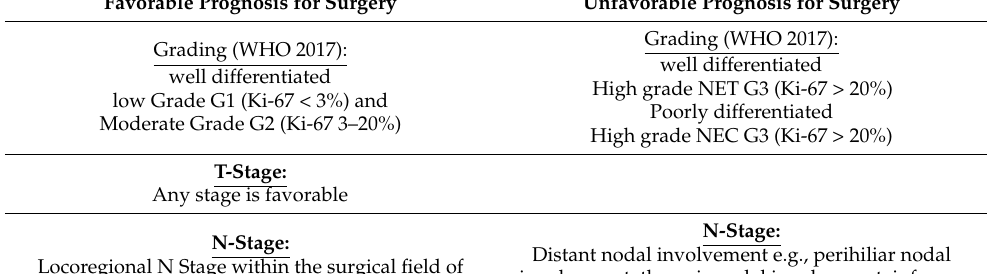
Table 2. Prognostic factors for surgery of advanced pancreatic NET in the metastatic setting. Favorable Prognosis for